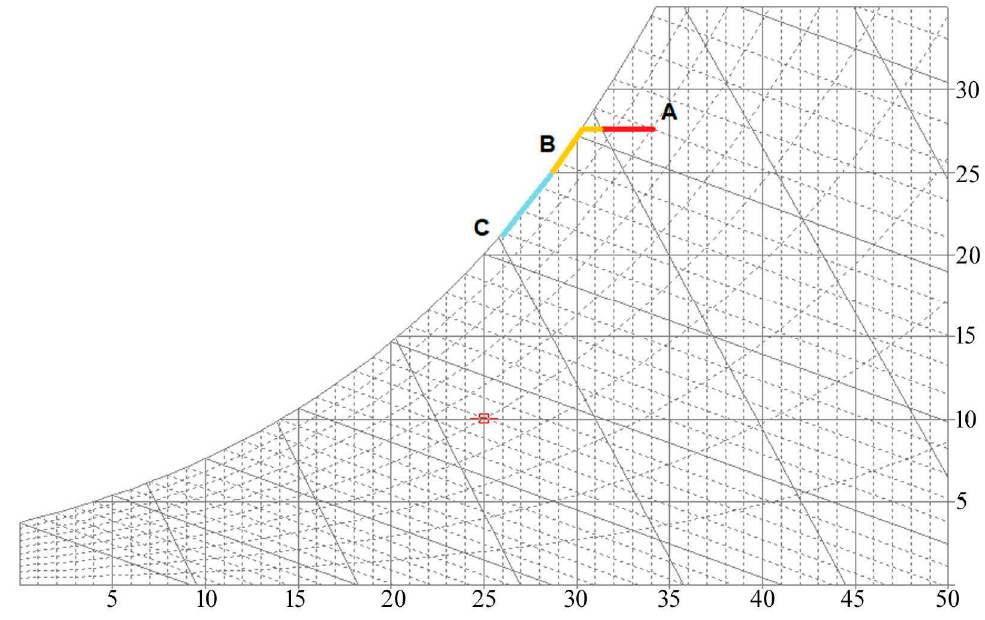
Figure 8. Transformation on the Ashrae Diagram (15 January).